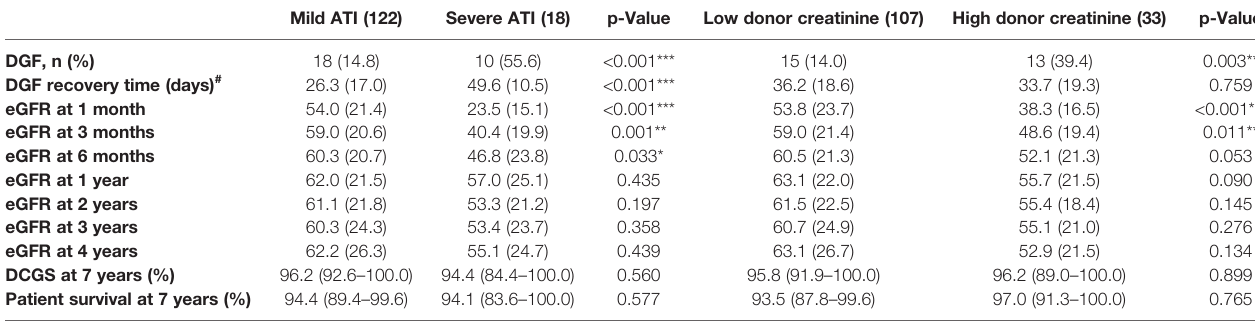
TABLE 2 | Comparison of posttransplant allograft outcome based on the severity of ATI and the level of donor terminal serum creatinine.